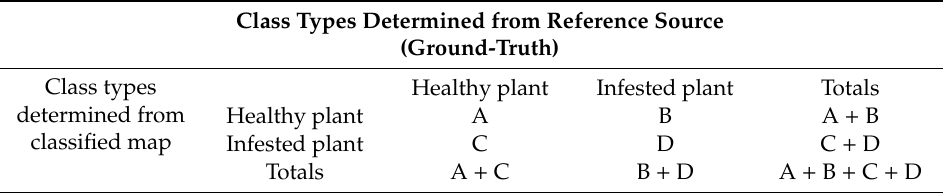
Table 1. Confusion matrix to evaluate classification